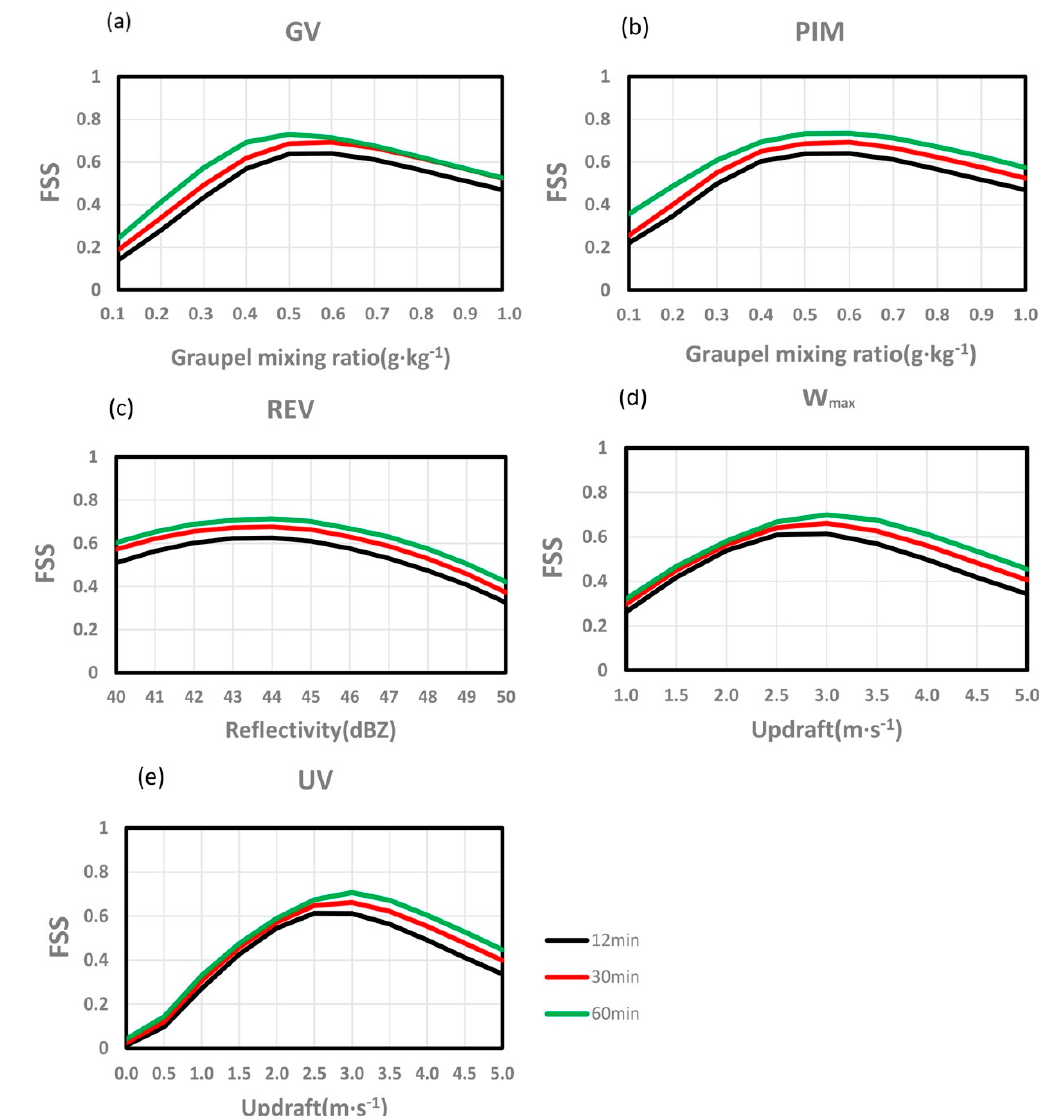
Figure 3. FSS of the simulated lightning flash rates for the different thresholds used to compute the corresponding volume for lightning diagnostic scheme using the proxy of ( a ) GV, ( c ) REV and ( e ) UV. FSS of the simulated lightning flash rates for the different filter thresholds for lightning diagnostic scheme using the proxy of ( b ) PIM and ( d ) W max . The abbreviations of each proxy are defined in Section 3.2.